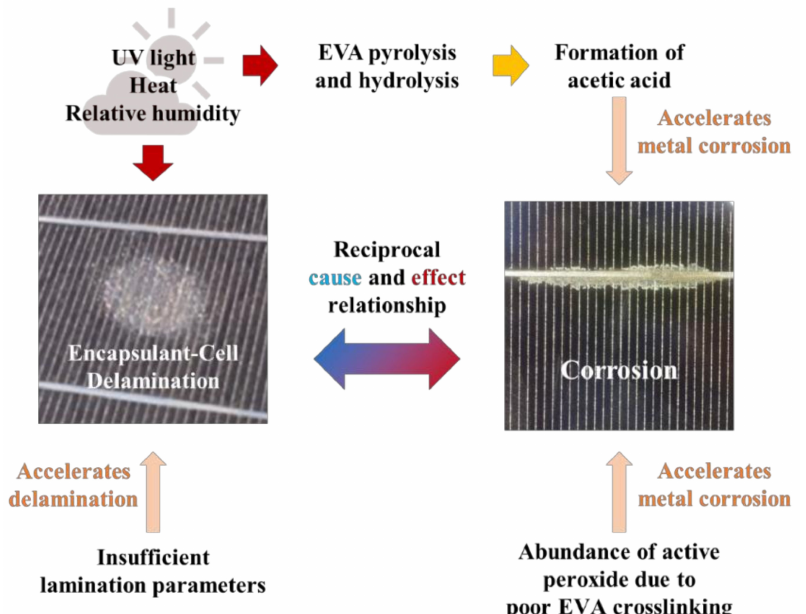
Figure 5. Corrosion mechanism in silicon solar cells [42,44,45,48]. H 2 O and O 2 enter through the backsheet or frame edges and penetrate a delaminated encapsulant-cell gap; hydrogen gas is formed during corrosion. The gas bubbles can grow and merge, which increases delamination.